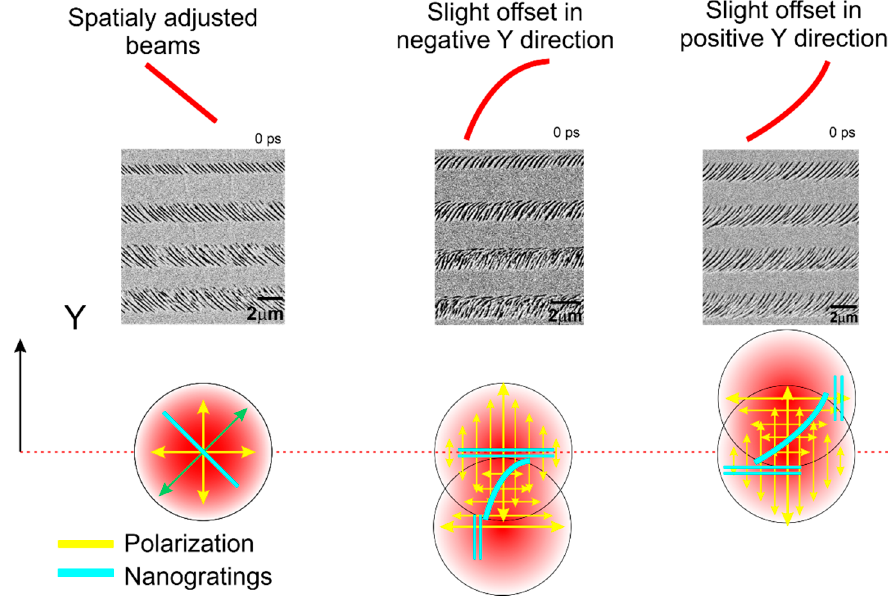
Figure 6. The pictorial explanation of the nanograting shape only for temporally adjusted pulses (0 fs delay) when a slight spatial beam misalignment is induced in the Y direction.